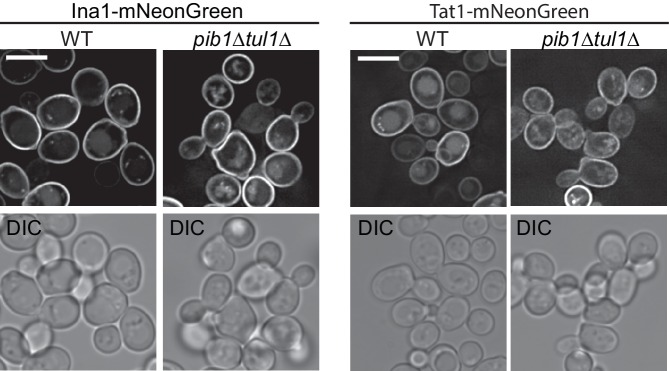
Plasma membrane proteins Ina1 and Tat1 were tagged with mNeonGreen and visualized in WT (wild-type) and pib1∆ tul1∆ double mutant cells by fluorescence microscopy.Vacuoles are more fragmented in the pib1∆ tul1∆ strain, but no difference was noted in the marker distribution between internal and plasma membrane pools. Scale bar represents 5 µm.